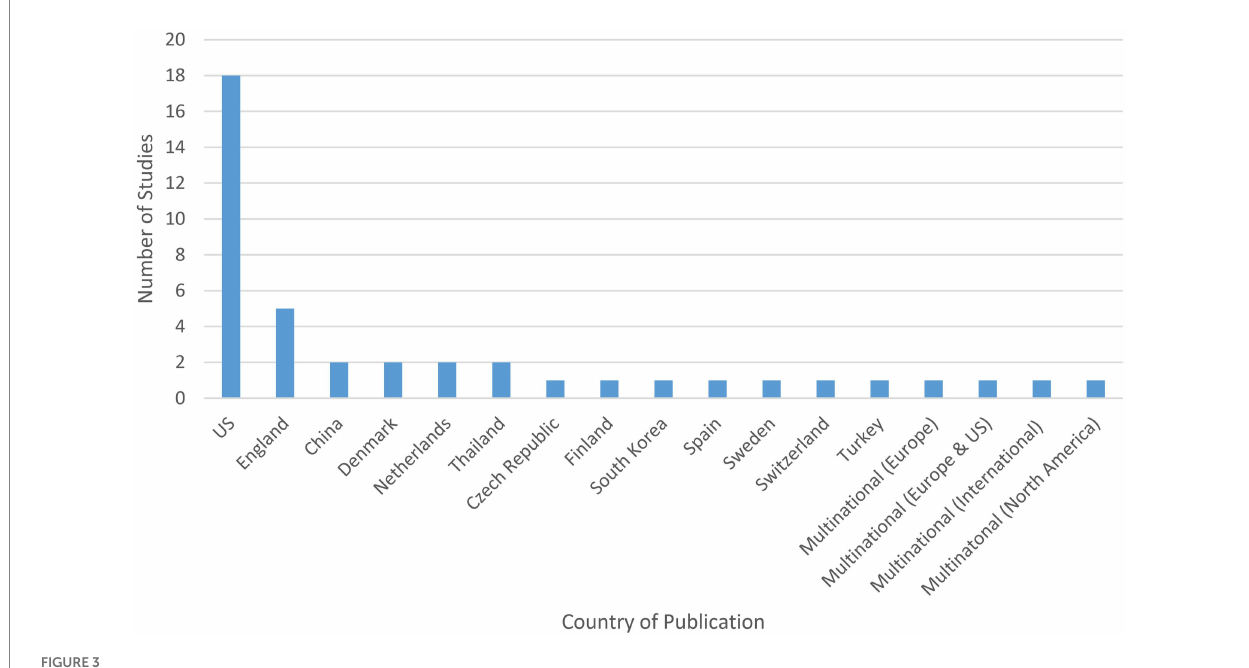
FIGURE 3 Study site of included